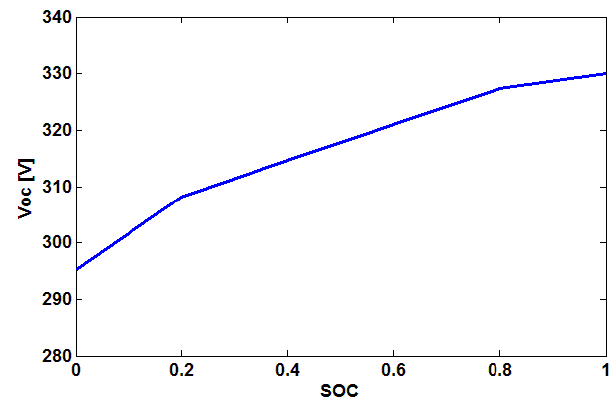
Figure 5. Fitting results of the open circuit voltage and soc .